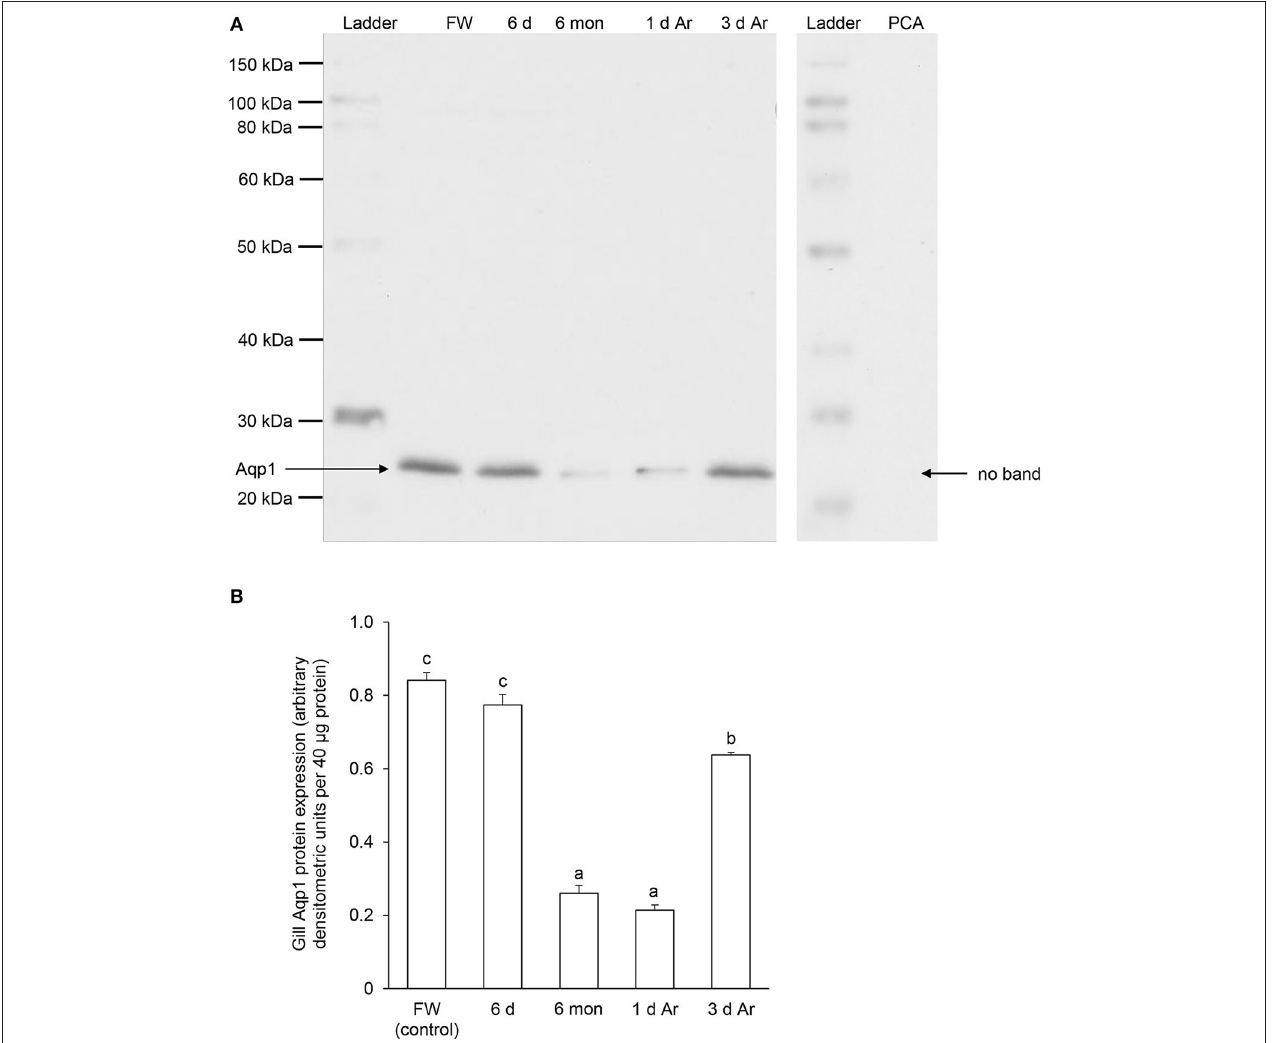
FIGURE 8 | The protein abundance of aquaporin 1 (Aqp1) in the gills of Protopterus annectens kept in fresh water on day 0 (FW; control), after 6 days (d; induction phase) or 6 months (mon; maintenance phase) of aestivation, or after 1 or 3 d of arousal (Ar) from 6 mon of aestivation. (A) An example of immunoblot of Aqp1 (left) and Aqp1 preincubated with immunising peptide for the peptide competition assay (PCA; right). (B) The protein abundance of Aqp1 expressed as arbitrary densitometric units per 40 µ g protein. Results represent mean ± S.E.M. ( N = 3). Means not sharing the same letter are significantly different ( P <